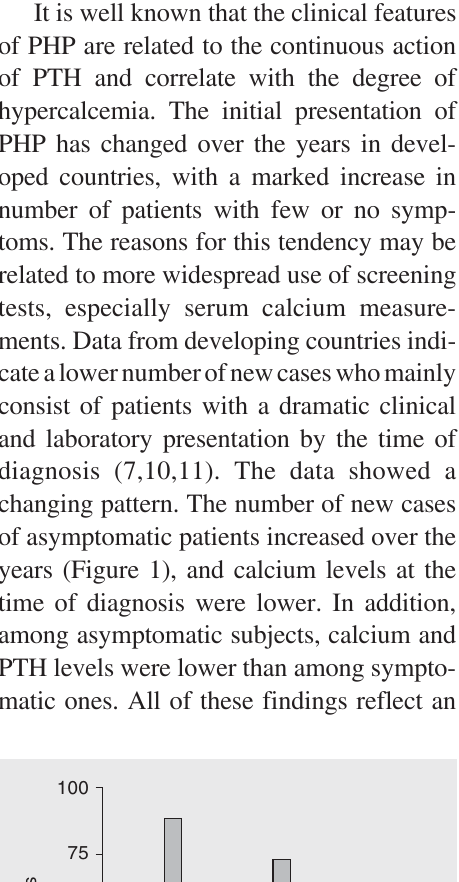
Figure 1. Percentage of sympto- matic and asymptomatic hyper- parathyroidism patients diag- nosed from 1985 to 2002 at our University Hospital. Data are re- ported for 64 symptomatic and 40 asymptomatic